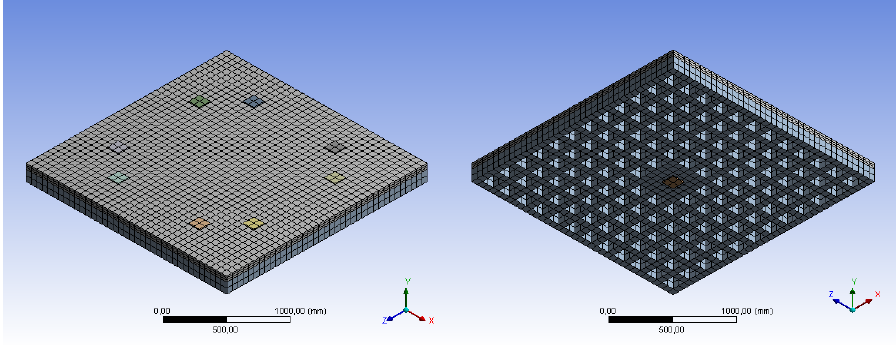
Figure 8. Slab model (Slab